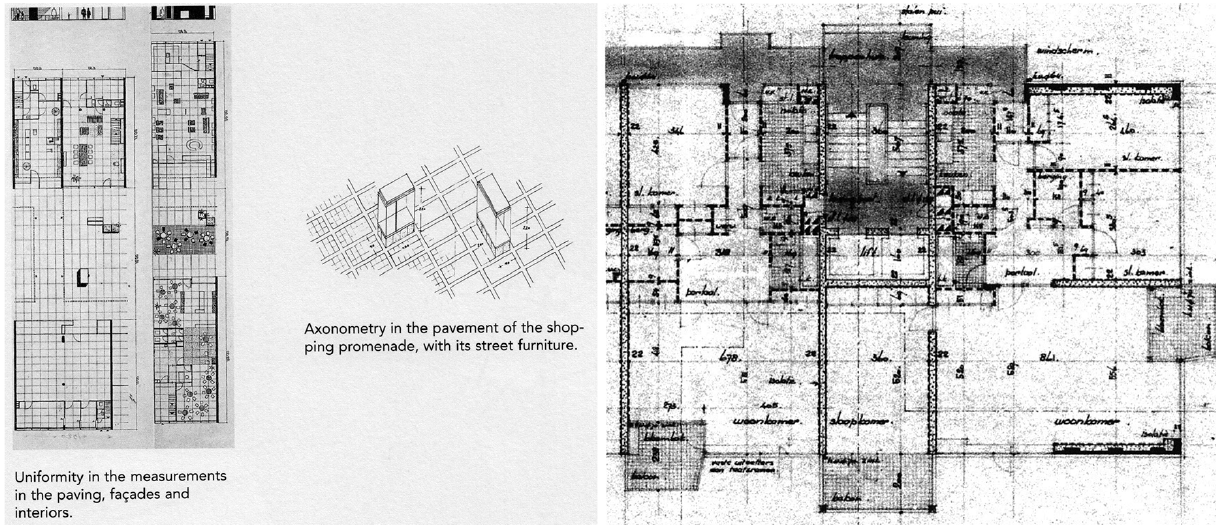
Figure 5. Original drawings of a floor plan of the apartments by H. A. Maaskant, 1:200 scale, with interior measurement system. Source: Komossa, Meyer, Risselada, Thomaes and Jutten (2005, pp. 164, 169).